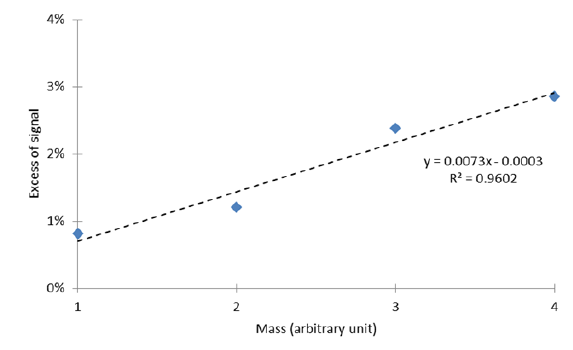
Fig. 14. Experimental results obtained for various masses of aluminum.